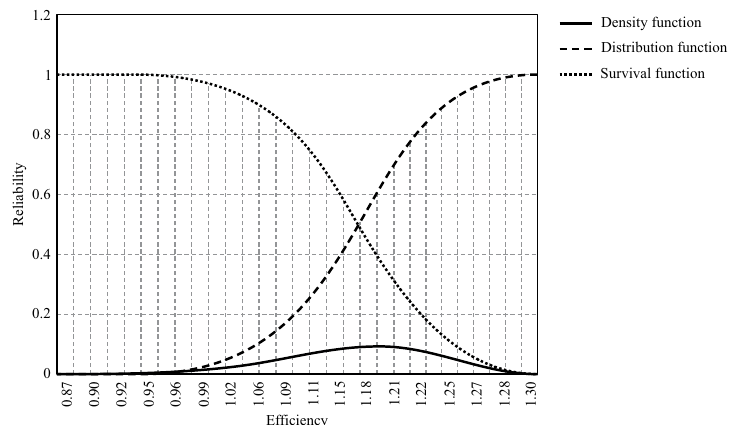
Fig. 5. Distribution of the probability of possibilities of the integral attribute multiplier effect